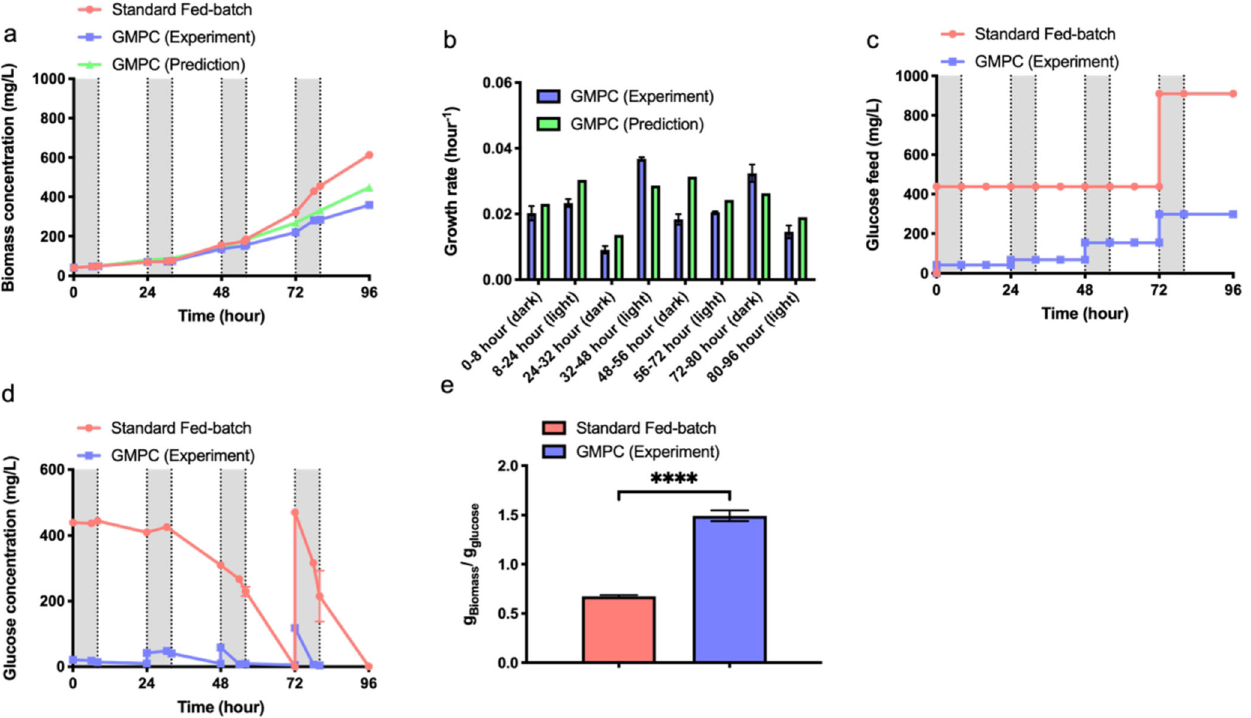
Fig. 4 Comparison between closed-loop GMPC with standard fed-batch cultures. a Cell growth. b Growth rate comparison between GMPC (Experiment) and GMPC (Prediction). c Glucose supply during the cultures. d Glucose level in the media. e Biomass yield on glucose. The data represents the mean ± SD for n = 3 (technical triplicates). **** P ≤ 0.0001 (GraphPad unpaired t